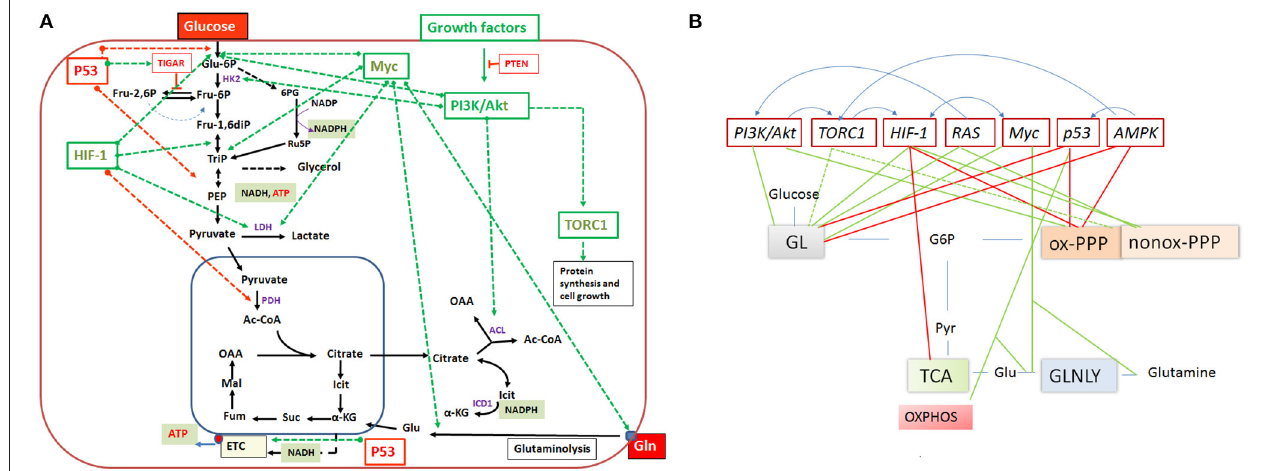
FIGURE 5 | (A) Important regulators of the mammalian cell metabolism are (proto)-oncogenes and tumor suppressors and interacting regulatory factors (e.g., PI3K/AKT, RAS, Myc, TORC1, HIF-1 and P53, PTEN, TIGAR, respectively) that control key reactions of the central catabolic pathways (including glutaminolysis) either positively (green dashed arrows) or negatively (red dashed arrows). (B) A schematic overview on the catabolic pathways including glycolysis (GL), pentose phosphate pathway (PPP), tricarboxylic acid (TCA) cycle and glutaminolysis (GLNLY) controlled by these key regulators. Green lines indicate upregulation of catabolic pathways and red lines downregulation of the pathways. Anabolic pathways (i.e., those leading to synthesis of nucleotides, amino acids, glutathione, lipids) which depend on intermediates of the catabolic pathways are (indirectly) also influenced by these regulators. The blue arrows above the regulators indicate interactions between them. See text for further details.